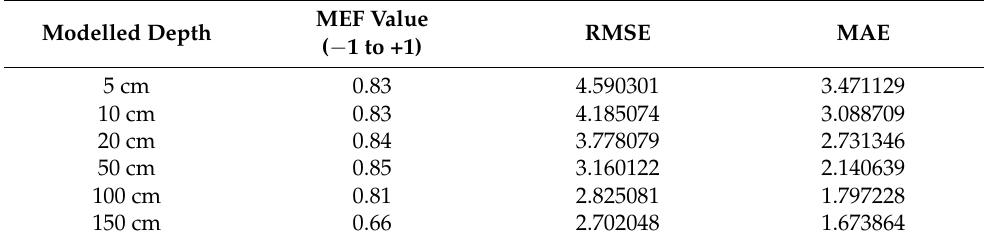
Table 4. Modelling efficiency (MEF), root mean square error (RMSE) and mean absolute error (MAE) calculation for the CanESM2 model